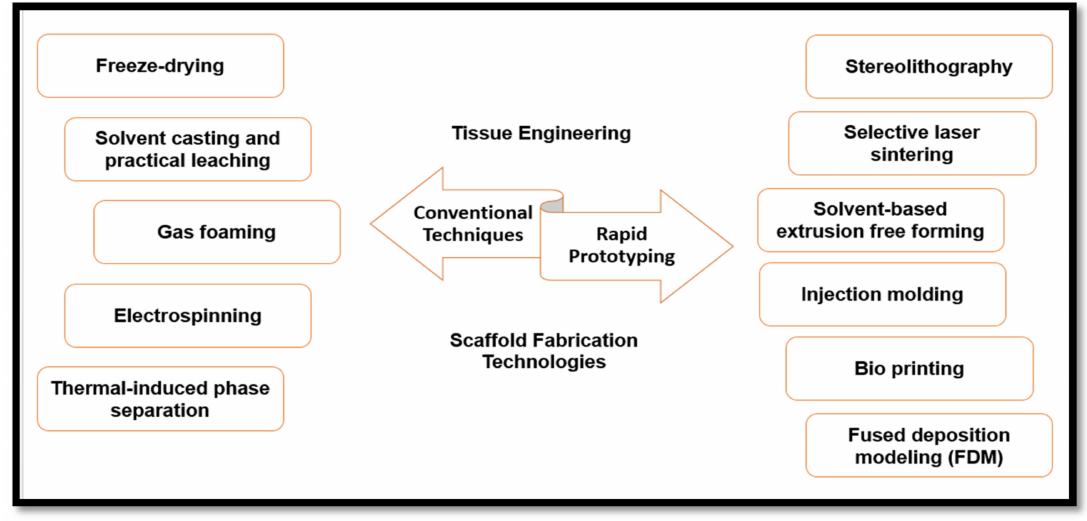
Figure 5. Types and classification of sca ff old fabrication technologies of micro- and nanocellulose-based materials.